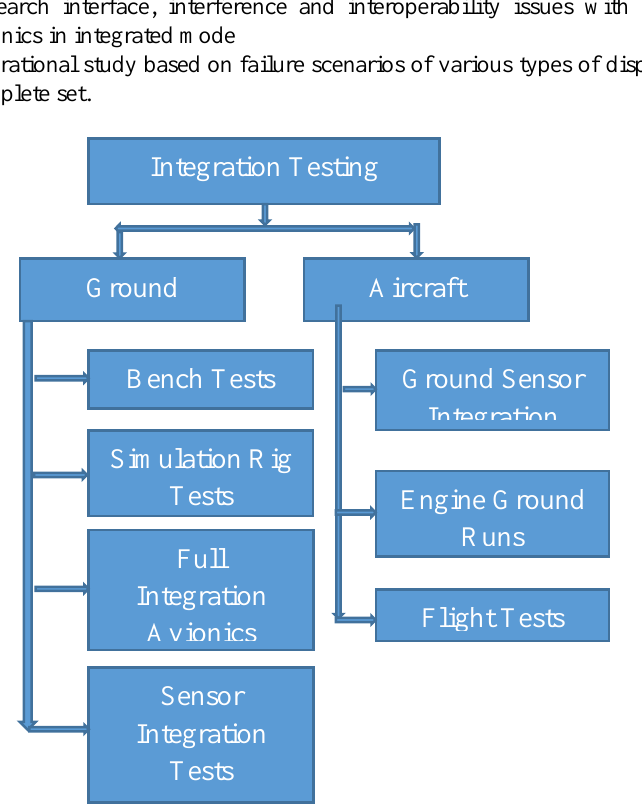
Fig. 5. Avionics system integration test